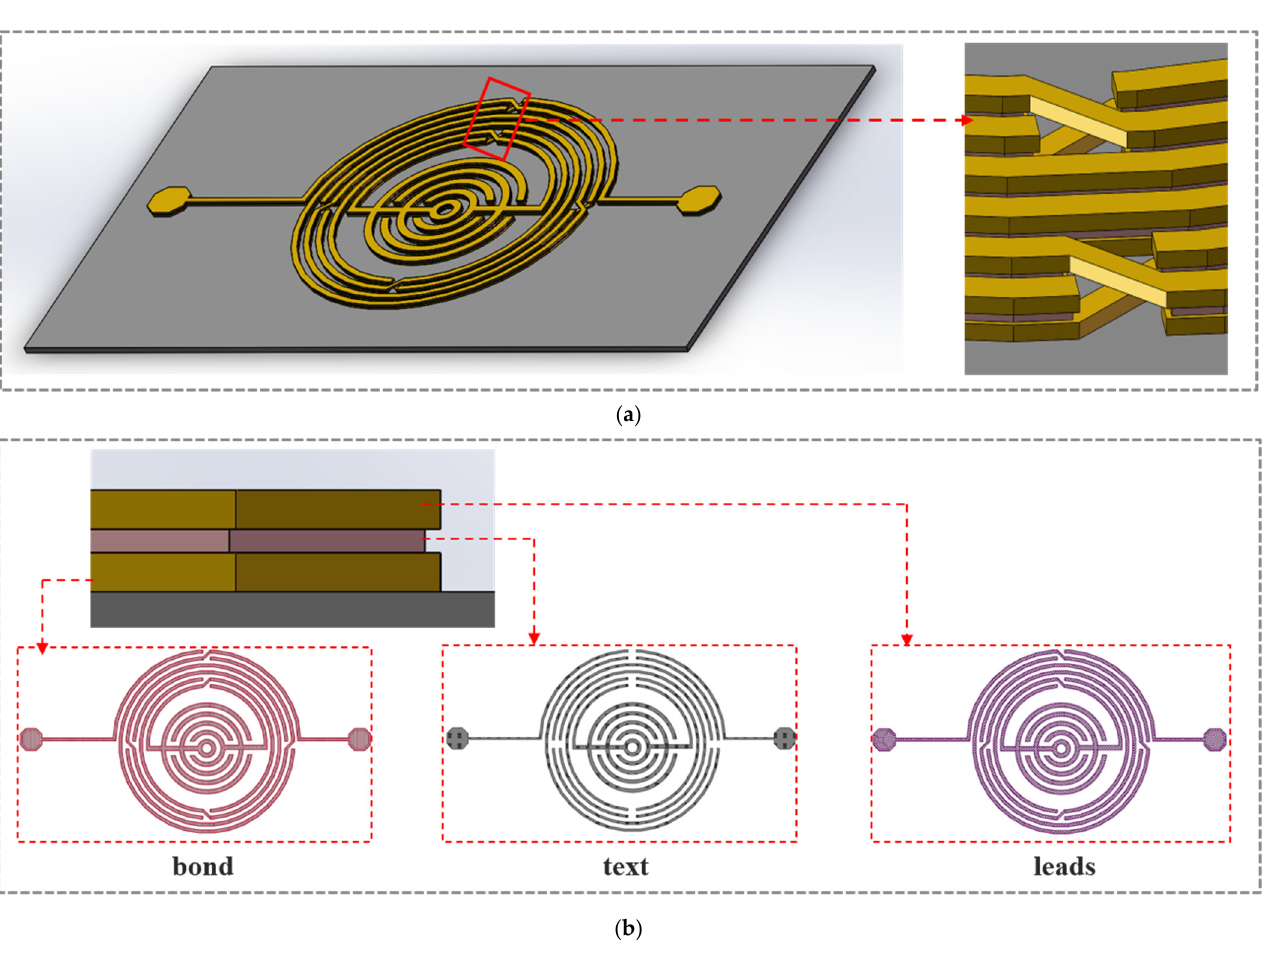
Figure 1. Pattern design of the proposed BPF: ( a ) stereo view of the BPF on a GaAs substrate and enlarged view of the air-bridges; ( b ) side view and three metal layers (leads, text, and bond).